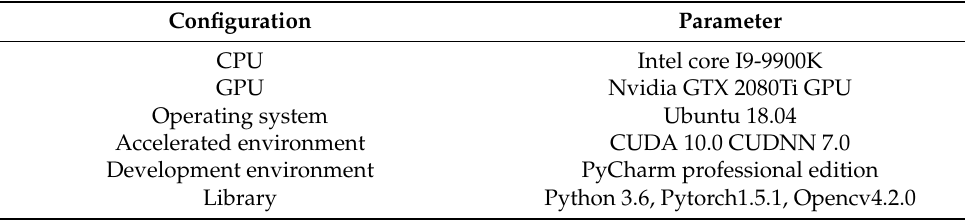
Table 2. Experimental environment.